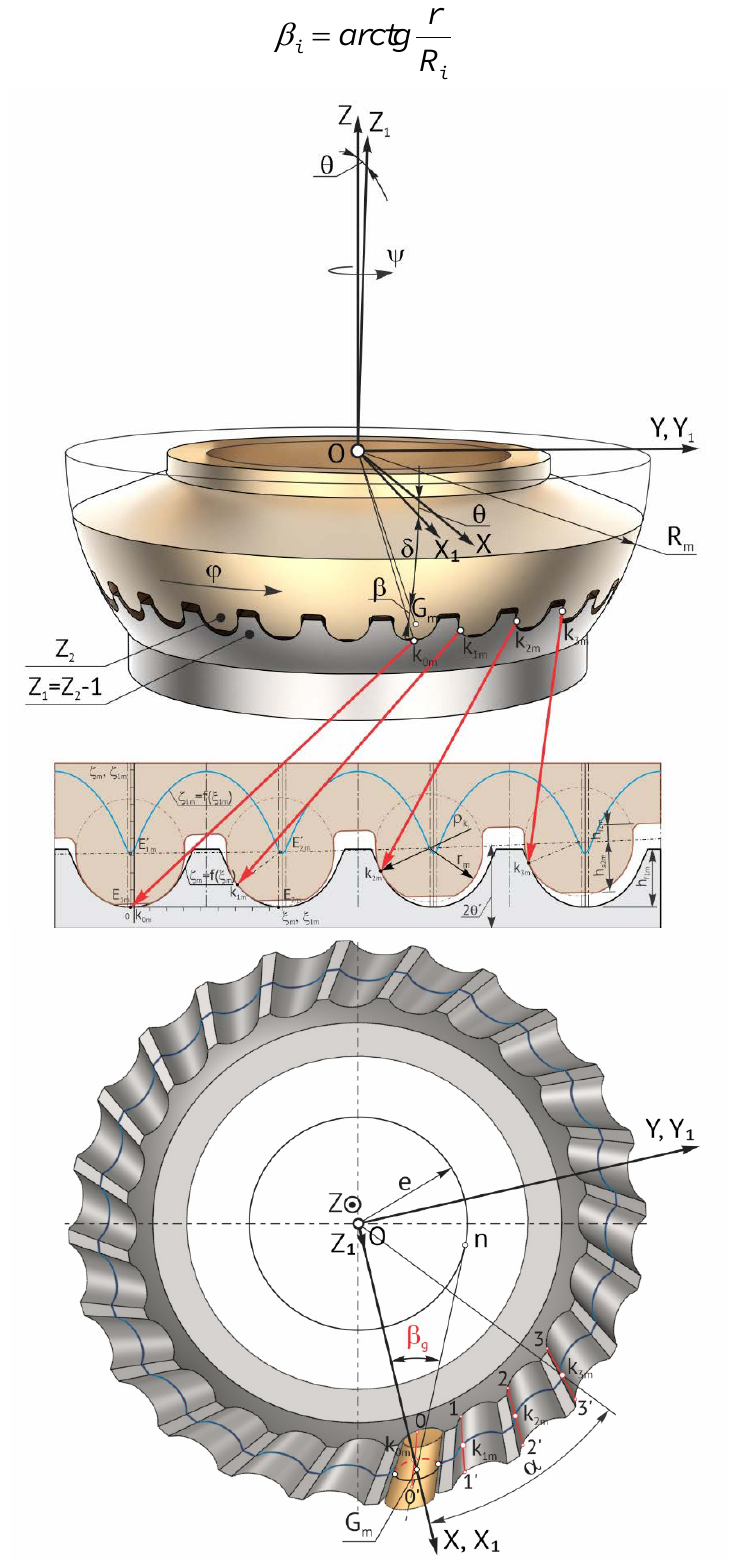
Figure 4. Evolution of the variation of the summary contact lines of the inclined